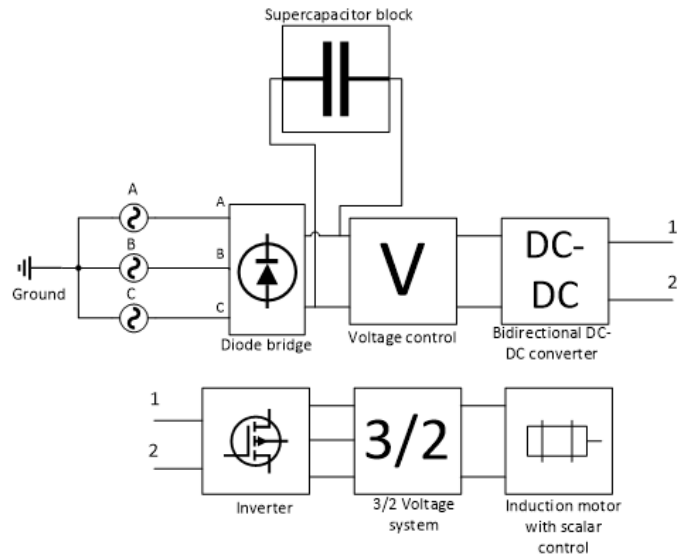
Figure 7. Model of the entire system.